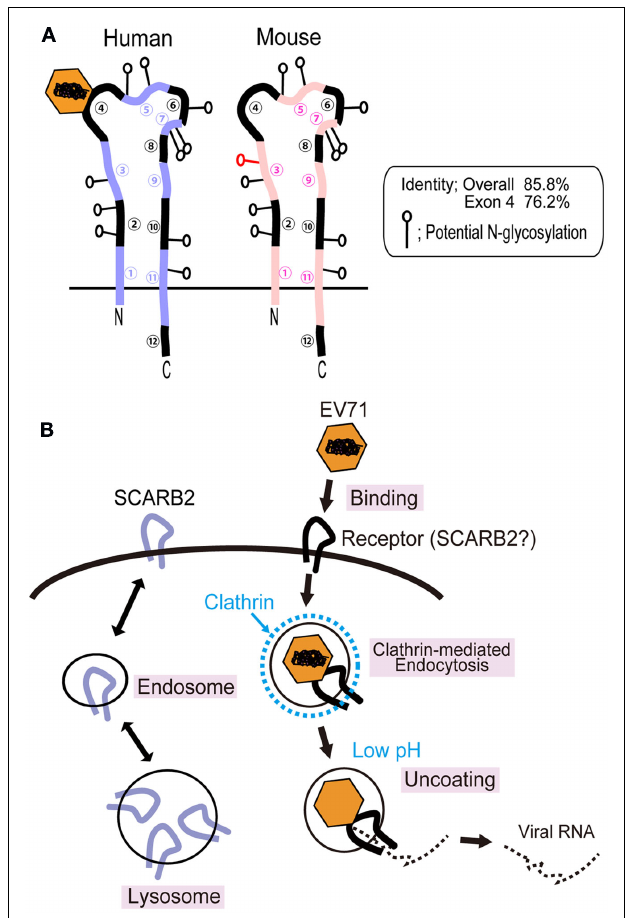
FIGURE 2 | Scavenger receptor class B, member 2 and EV71 infection in RD cells. (A) Comparison of the structures of human and mouse SCARB2.The human and mouse SCARB2 proteins are type III transmembrane proteins consisting of 478 amino acids.The amino acid identity of human SCARB2 to mouse SCARB2 is 85.8%. Because mouse SCARB2 does not serve an efficient receptor, it is possible to identify the virus binding site using chimeric receptors including mouse and human sequences.The 63-amino-acid region that is encoded in exon 4 of the human SCARB2 gene plays an essential role in EV71 binding and infection. (B) Mechanism of EV71 infection in RD cells.The SCARB2 protein is located in the lysosomal and endosomal compartments and shuttles to the plasma membrane.This protein is able to bind EV71 when present at the cell surface. Hussain et al. (2011) have shown that EV71 infection is dependent on the clathrin-mediated endocytosis pathway by knockdown of the expression of proteins that participate in clathrin-mediated endocytosis. EV71 infection is also inhibited when cells are treated with drugs that block acidification of the